Question: Compose a caption that would accompany this figure in a paper.
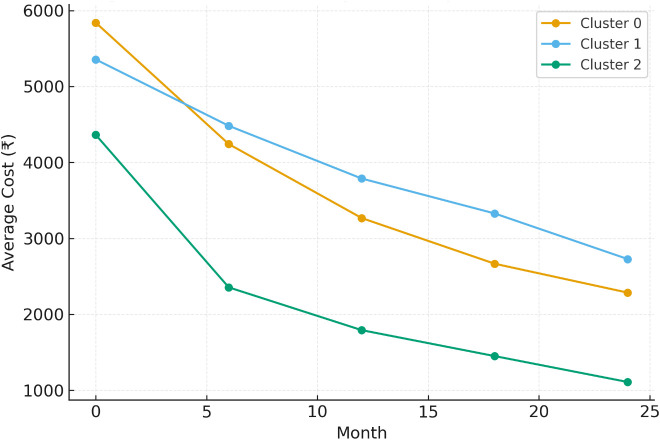
Answer: Mean cost trajectories per cluster (k=3).